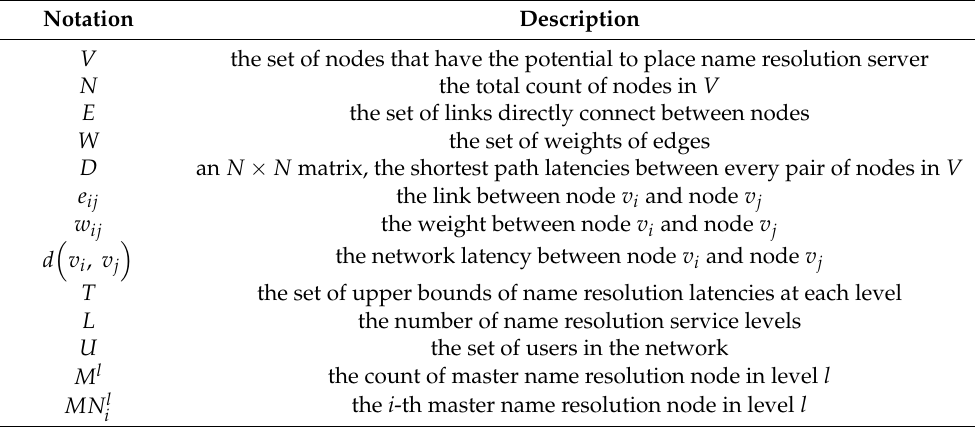
Table 1. Summary of